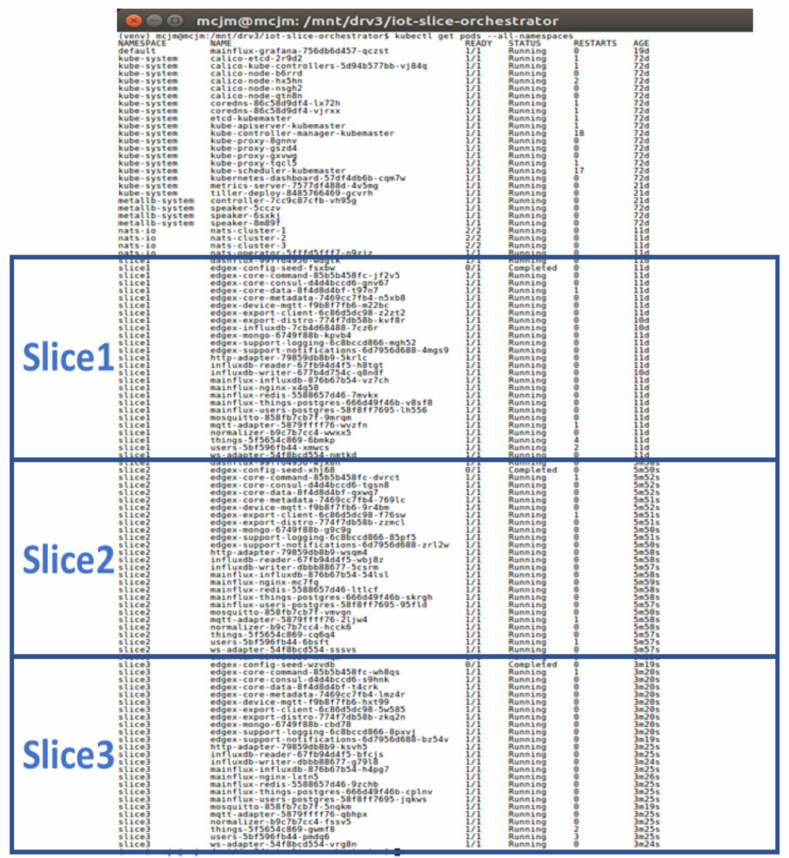
Figure A6. Example of three slices deployed in a custom Kubernetes